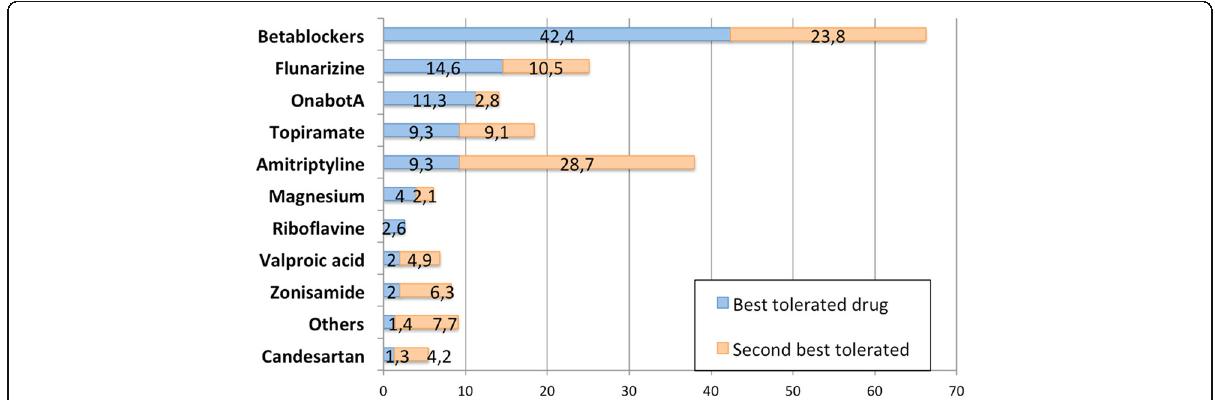
Fig. 2 Best tolerated drugs according to responders ’ opinions. In light blue, percentage of responders that selected each drug as the best tolerated. In light orange, percentage of responders that selected each drug as the second best tolerated. Number represents